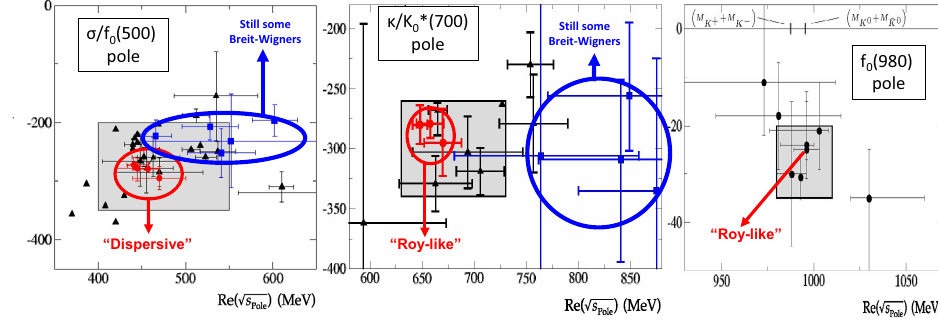
√ s pole = M − i Γ / 2. We have (700) 0